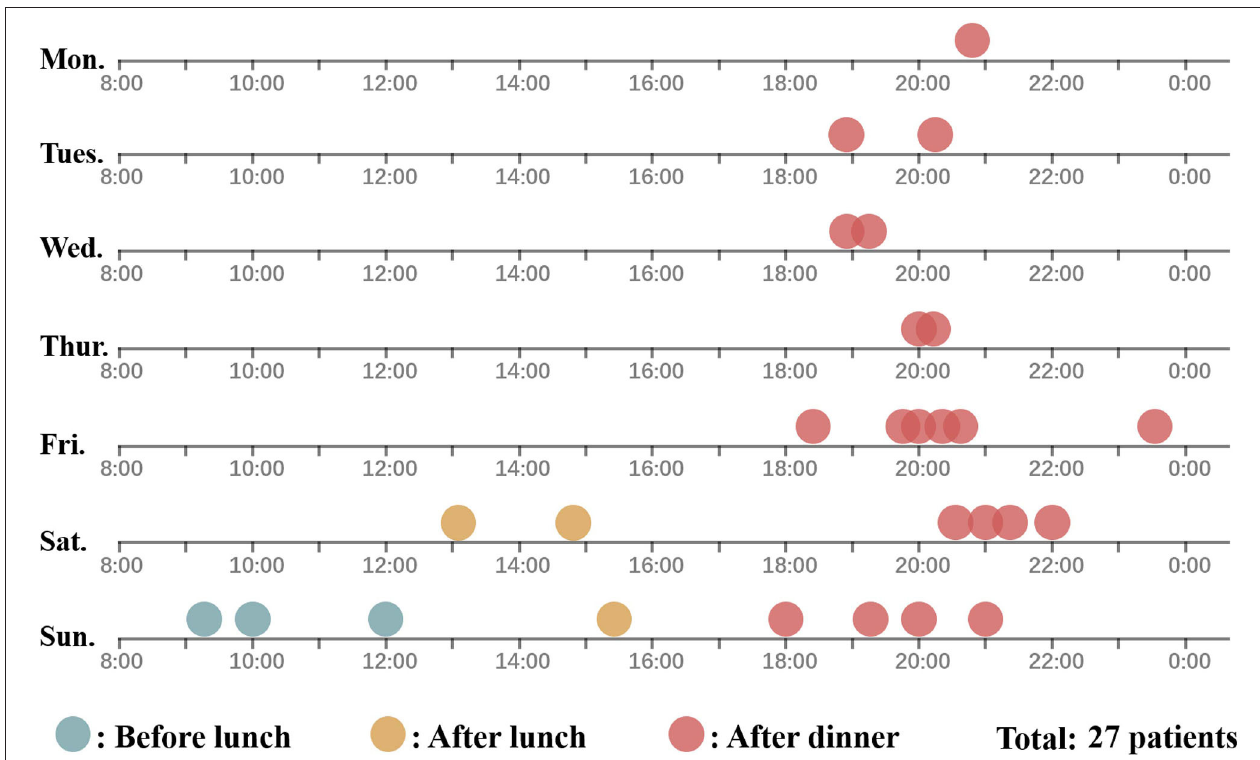
FIGURE 4 | The time of injury in 27 patients according to the day of the week and the time of the day. The time of injury in “trauma group” and “early complication group” (27 patients) are depicted in this figure. A dot represented a patient. Blue, yellow, and red represent the injury that occurred before lunch, between lunch and dinner, and after dinner. Data in “scar contracture” group were not included because the first-hand data were unavailable, and their parents failed to recall the exact time of